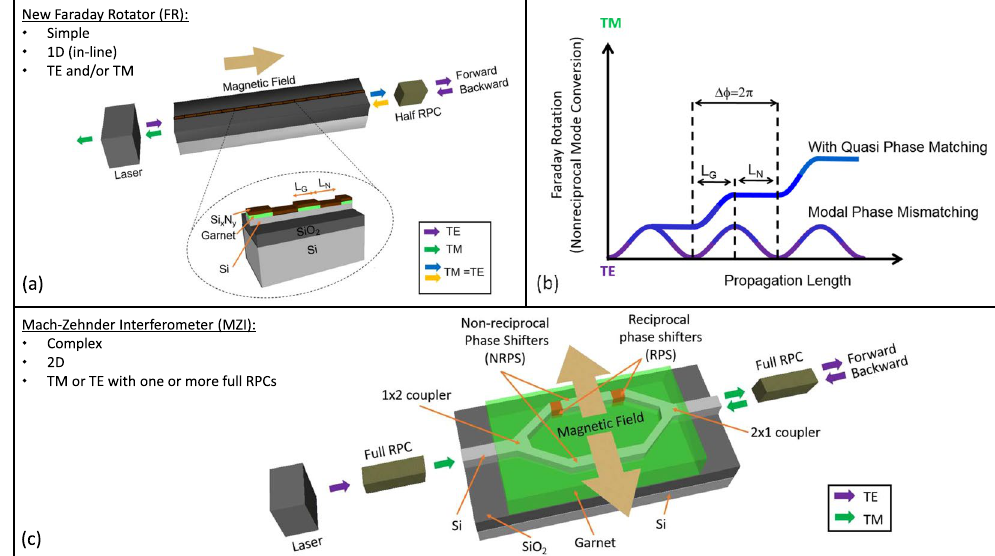
Figure 1. Comparison of a Faraday Rotation waveguide vs the simplest form of a Mach-Zehnder Interferometer (MZI), both as TE-mode isolators on Si-on-insulator (SOI) waveguides with garnet top claddings. ( a ) Schematic showing the components required for a Faraday Rotation waveguide isolator. The total isolator size is 4 mm × ~1 µ m. ( b ) Schematic showing both the effects of phase velocity mismatch (birefringence) and the solution: quasi phase matching (QPM). QPM can be used to periodically suspend Faraday Rotation, or more specifically mode conversion, by spatially varying the cladding such that the period L G + L N corresponds to a modal phase offset of Δϕ = 2 π . ( c ) Schematic showing the components required for the simplest MZI-based isolator. A total size of 4 mm × 0.2 mm has been achieved using serpentine MZI 20